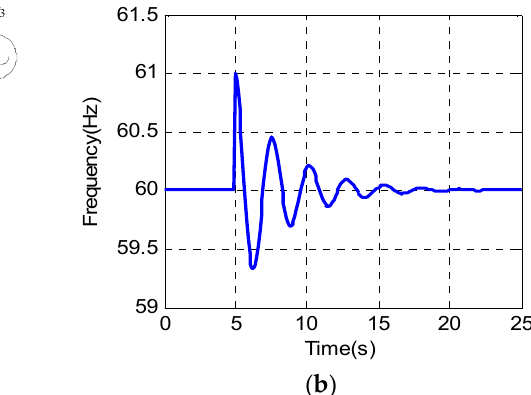
Figure 7. Comparisons of average estimation errors.